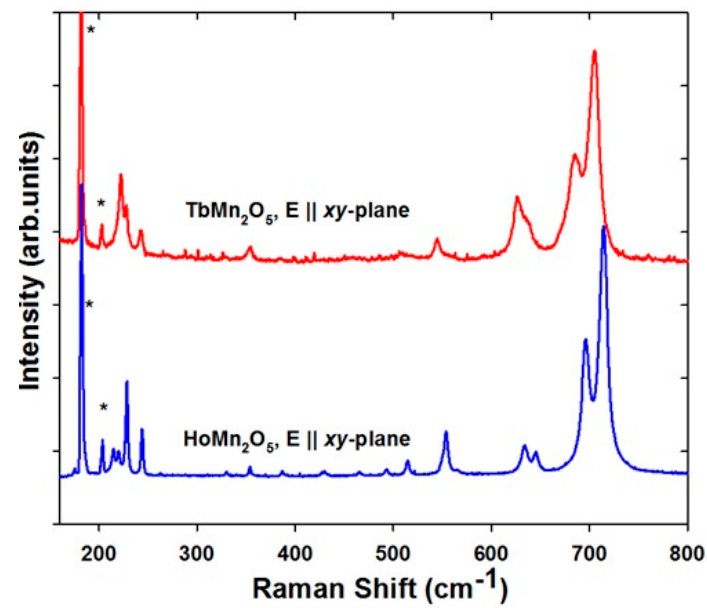
Figure 2. Micro Raman spectra at 5 K for the orthorhombic single crystals RMn 2 O 5 (R = Ho, Tb). The narrow excitations demonstrate the high quality of the crystals and confirm the orthorhombic symmetry.